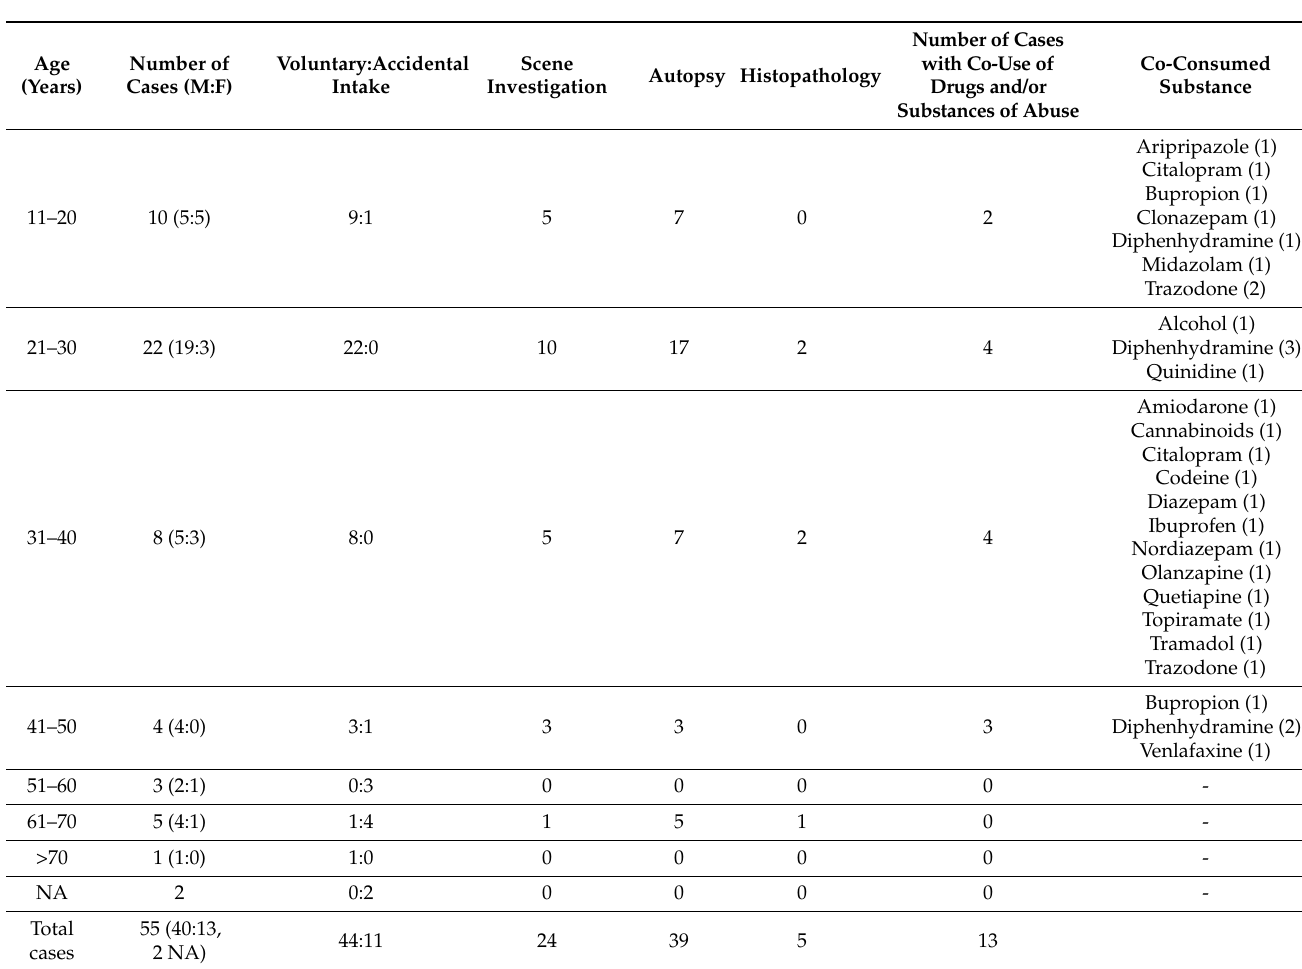
Table 2. Main characteristics of the deaths stratified by the age of the